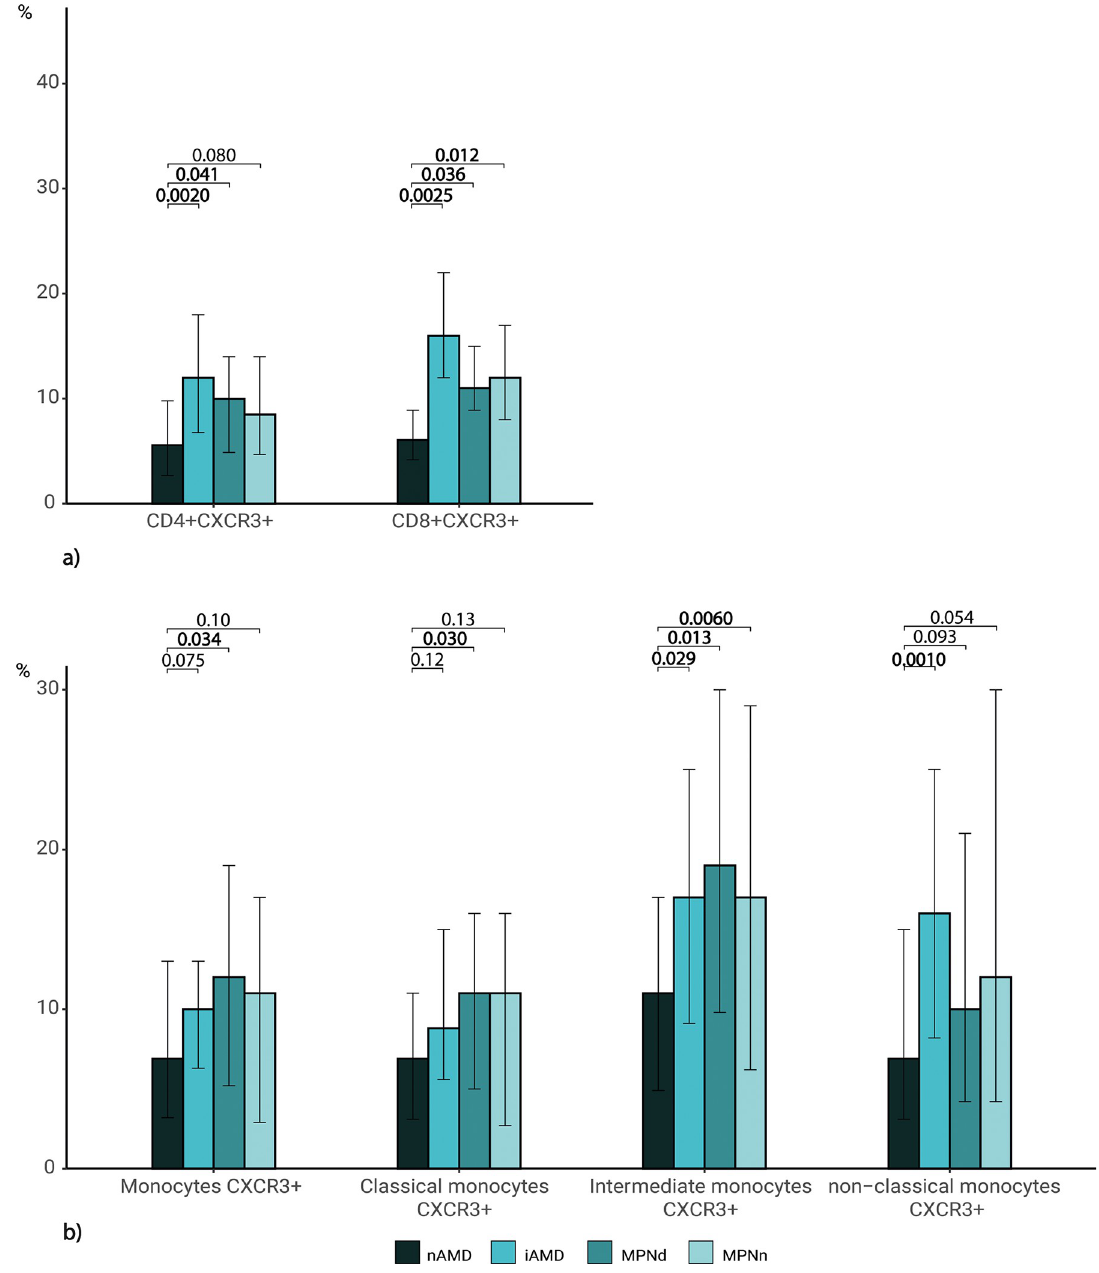
Fig 2. Lower CXCR3 expression on leukocytes in patients with nAMD. Median frequency (%) of leukocytes and leukocytes expressing CXCR3 in patients with neovascular AMD (nAMD), intermediate AMD (iAMD), myeloproliferative neoplasms with drusen (MPNd), and myeloproliferative neoplasms with normal retinas (MPNn) a) Expression of CXCR3 on T cells. b) Expression of CXCR3 on monocytes. Bars represent the interquartile range. Statistical comparison between groups: Kruskal Wallis or if the outcome depended on age, robust linear regression. Wilcoxon rank-sum test for multiple comparisons. Significant P-values are shown in